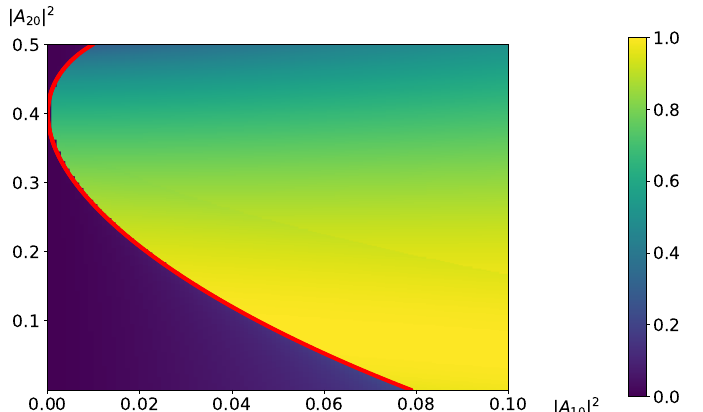
Figure 1. The LFW maximal intensity dependence on the incident LFW intensity and the incident IFW intensity. The boundary of domains corresponding to the high-effective and low-effective modes is depicted with a red solid